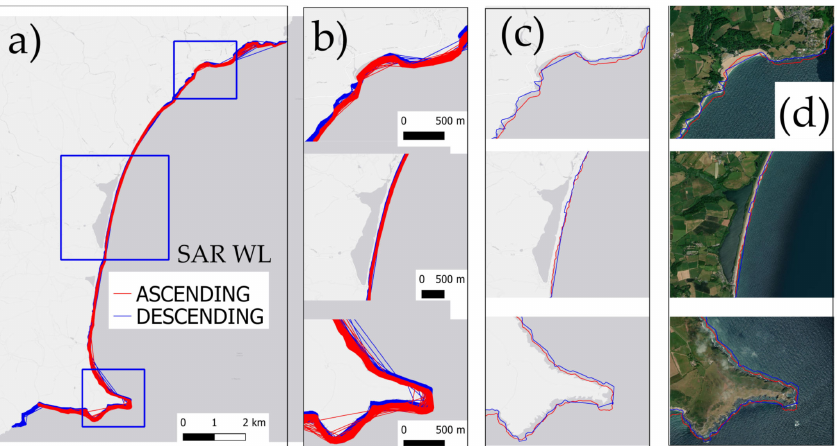
Figure 10. Waterlines and shorelines derived from Sentinel 1 between March 2016–October 2019 for the Start Bay study area; ( a ) SAR waterlines in red and blue for images taken on Ascending and Descending orbits respectively; ( b ) zoom to three different areas over a Light Gray Canvas Base map; ( c ) zoom to same areas shown in b but now with a single waterline extracted from image taken near high tide 17:57 UTC 4 February 2015 and 06:31 UTC 6 February 2015 taken on Ascending and Descending orbits; ( d ) zoomed view with aerial image as a base map and shoreline with same lines shown in panel c. Source of Light Gray Canvas Base map: Esri, HERE, Garmin, © OpenStreetMap contributors, and the GIS user community. Source of aerial imagery: Esri, Maxar, GeoEye, Earthstar Geographics, CNES/Airbus DS, USDA, USGS, AeroGRID, IGN, and the GIS User Community,